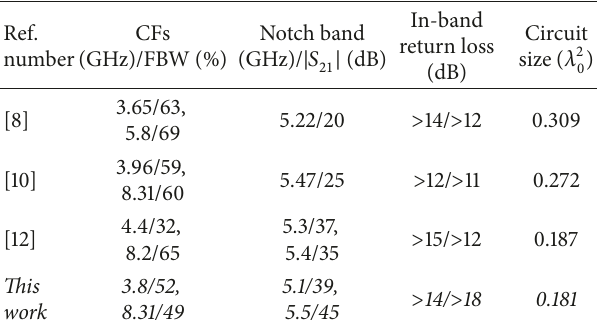
Table 1: Comparisons between referenced works and our work.